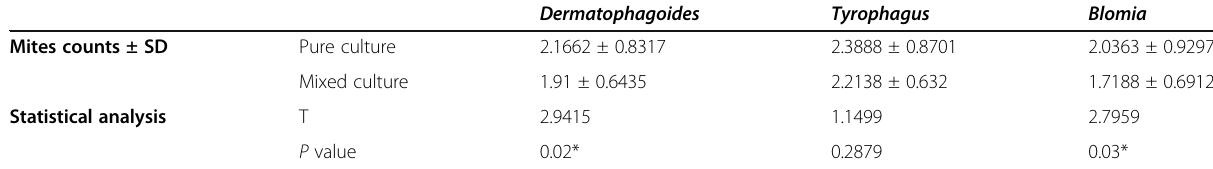
Table 3 The difference between growth rates in pure and mixed cultures for each studied mite